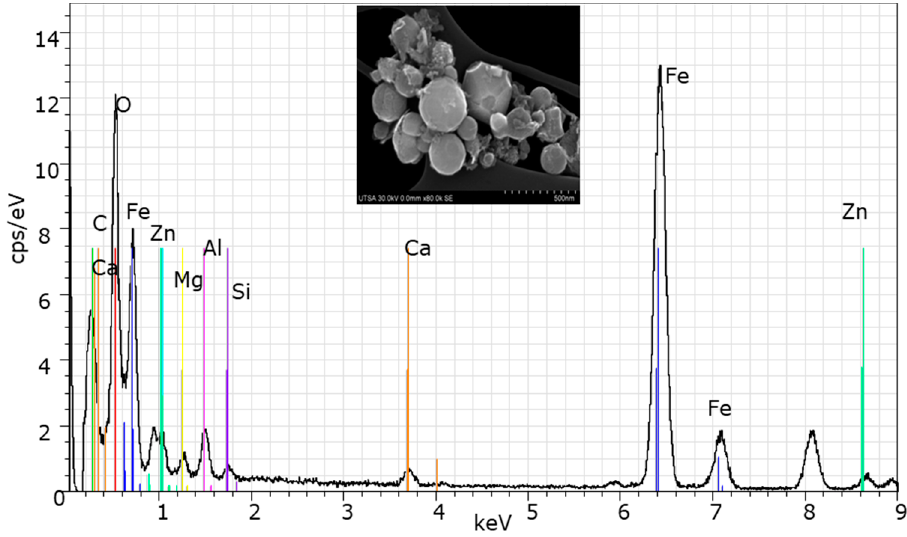
Figure 1. X-Ray diffraction pattern obtained for the BFS.